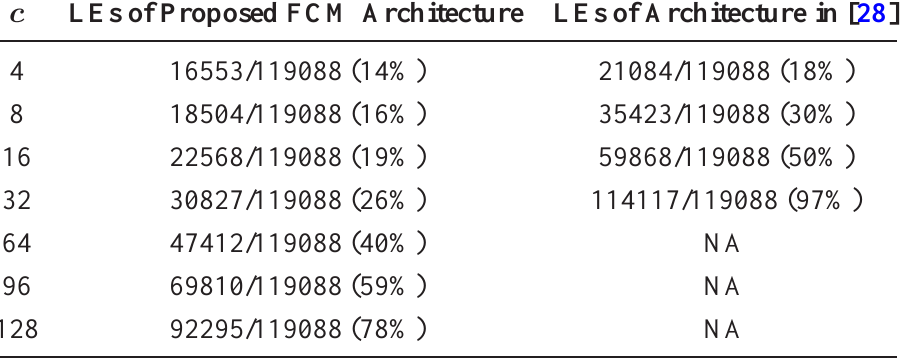
Table 9. Comparisons of the area costs of various FCM architectures with n = 2 × 2